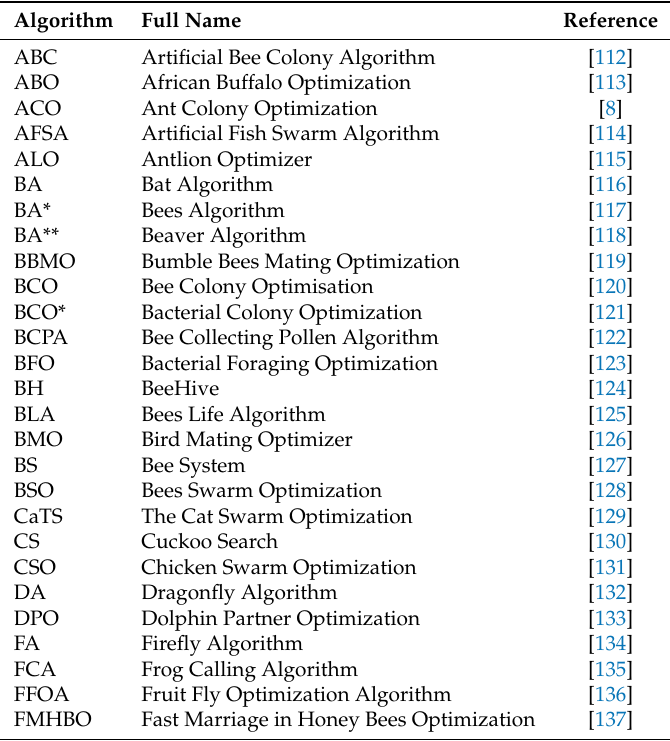
Table A1. Swarm Intelligence algorithms sorted by